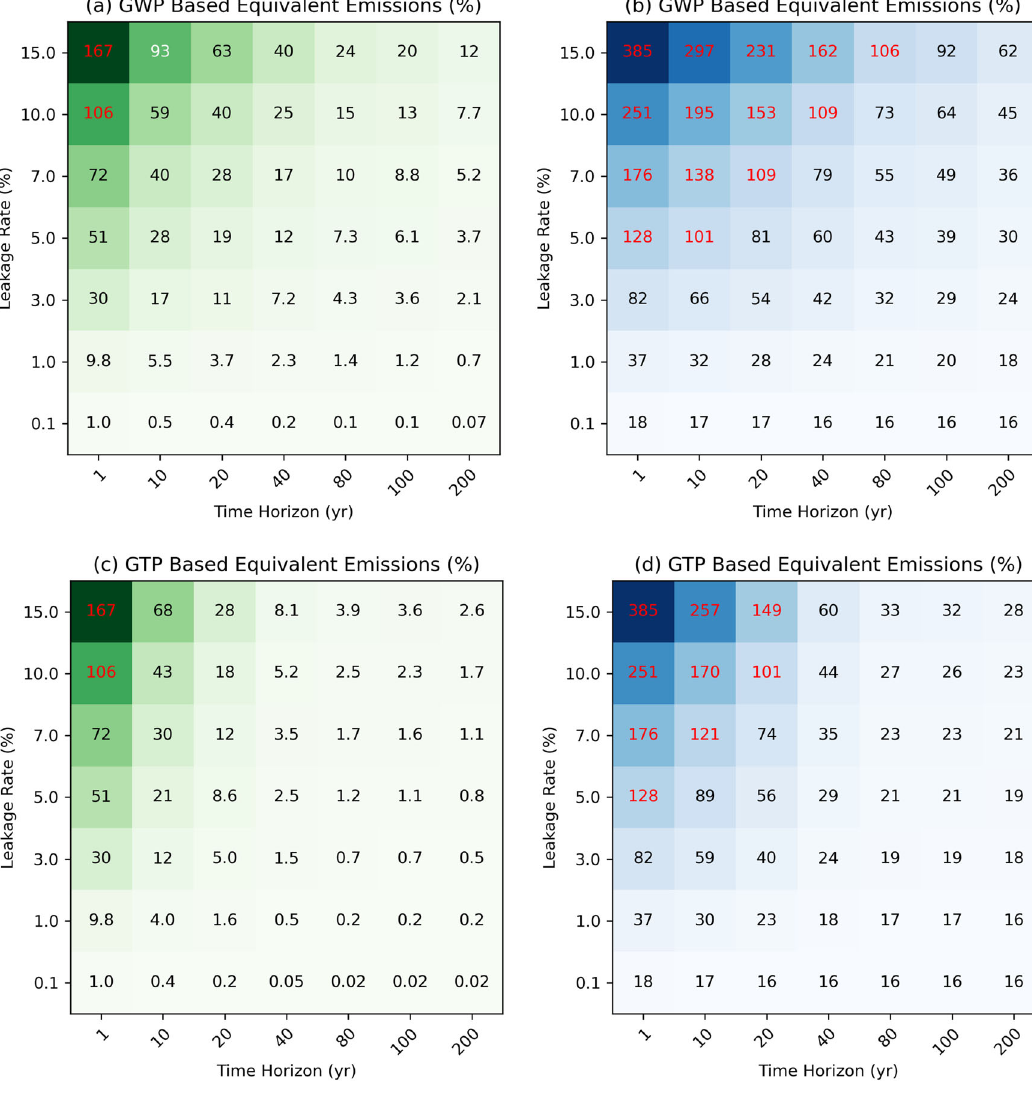
Fig. 2 Climate bene fi t of a global energy transition to hydrogen. Ratio (expressed in %) of CO 2 equivalent emissions associated with a hydrogen economy to the avoided CO 2 emissions as a function of the hydrogen leakage rate and the metric time-horizon. a , b GWP based emission ratios, c , d GTP based emission ratios. The emission ratios are calculated assuming a green hydrogen supply only (left) and assuming blue + green hydrogen with a 30% blue hydrogen supply as assumed in the HC2017 scenario for 2050 (right). The net climate penalty conditions (ratios > 100%) are